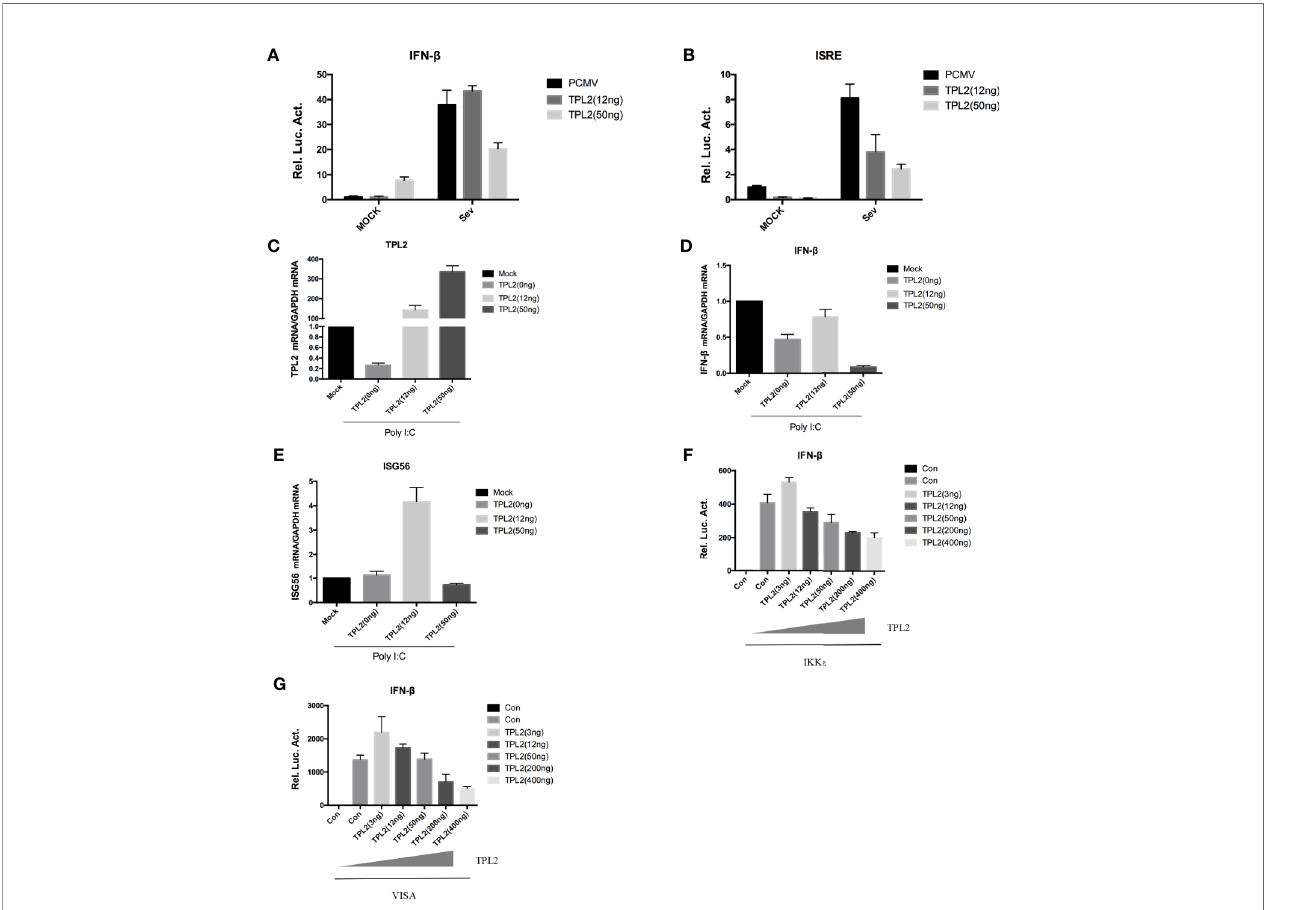
FIGURE 4 | TPL2 activates the IFN- b signaling pathway. (A, B) HEK293T cells were transfected with 3, 12, or 50 ng of TPL2 empty-loaded PCMV and TPL2 plasmids and then infected with SeV. Cells were collected 12 h later for dual-luciferase assays. (C – E) HEK293T cells were transfected with 12 or 50 ng of TPL2 unloaded PCMV and TPL2 plasmids. After 24 h, transfected cells were stimulated with poly (I:C) at 1 m g/ml for an additional 12 h. (F, G) HEK293T cells were transfected with exogenous mitochondrial antiviral signaling protein (MAVS) and IKK ϵ and evaluated with respect to dose-dependent expression of